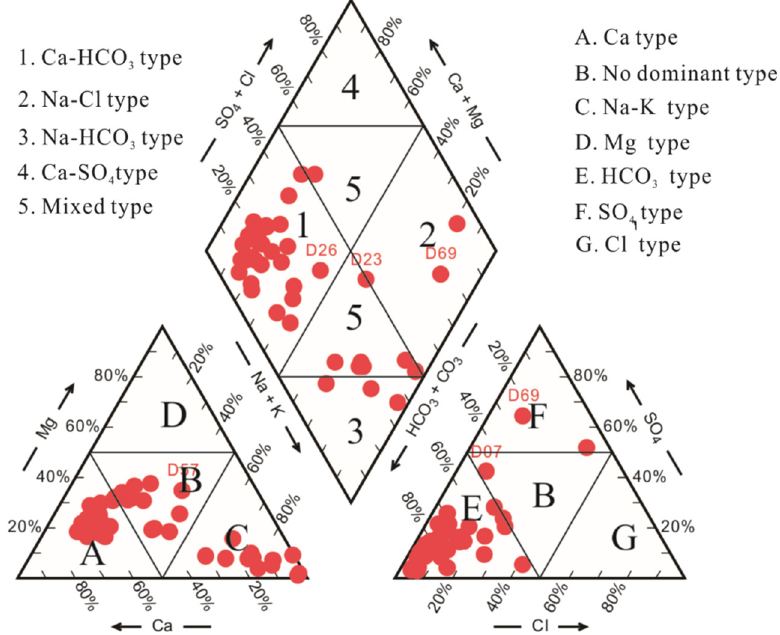
Figure 8. Piper diagram for the groundwater in the study area.